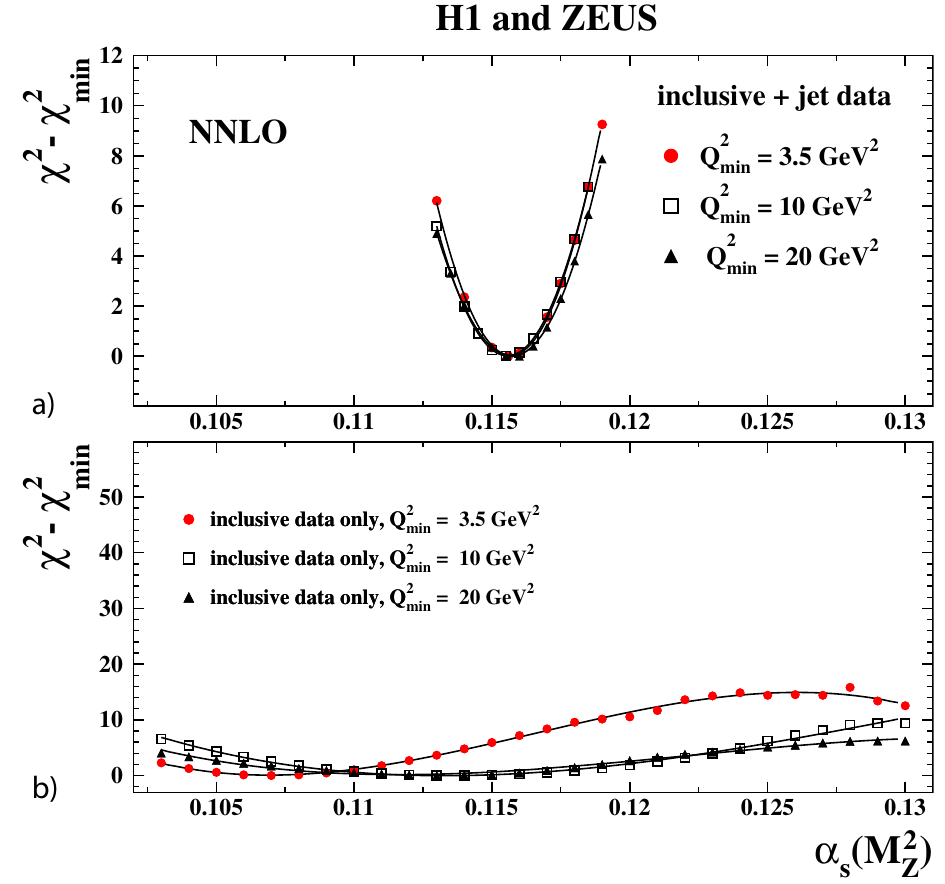
) for a versus α s ( M 2 10GeV 2 and 20GeV 2 . b For comparison, the situation for fits Z min ) with the stan- to only inclusive data, HERAPDF2.0 NNLO, is shown, taken Z from [2] set to min